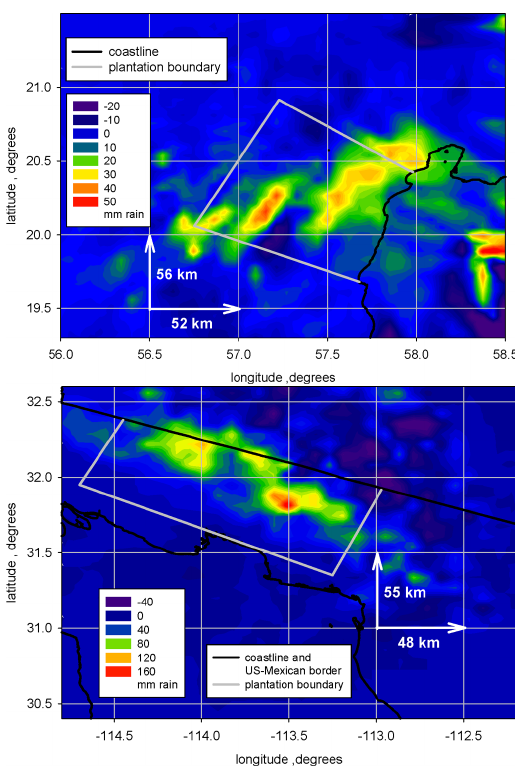
Fig. 6. Predicted differences in precipitation between planted and desert regions in Oman (upper panel) and Sonora (bottom panel) in summer